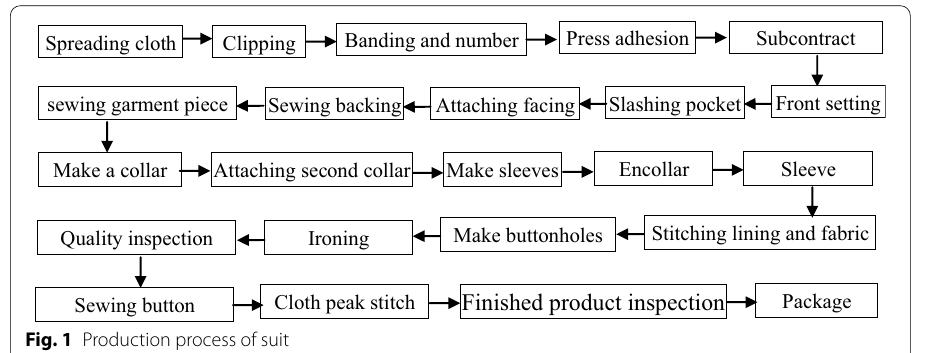
Fig. 1 Production process of suit